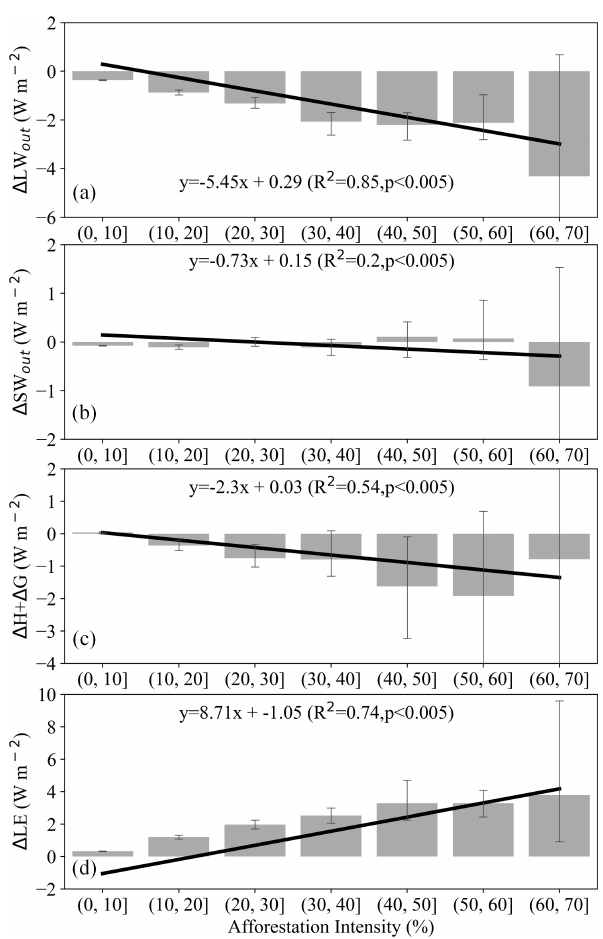
Figure A4. Changes of actual effect in (a) (cid:49) LW, (b) (cid:49) SW, (c) (cid:49)H + (cid:49)G , and (d) (cid:49) LE (Wm − 2 ) as a function of afforestation intensity ( F aff ) following the actual effect approach. Error bars indicate the standard error within each 10% percent bin of F aff . The solid black lines represent the fitted linear regression line between each energy flux variable and F aff